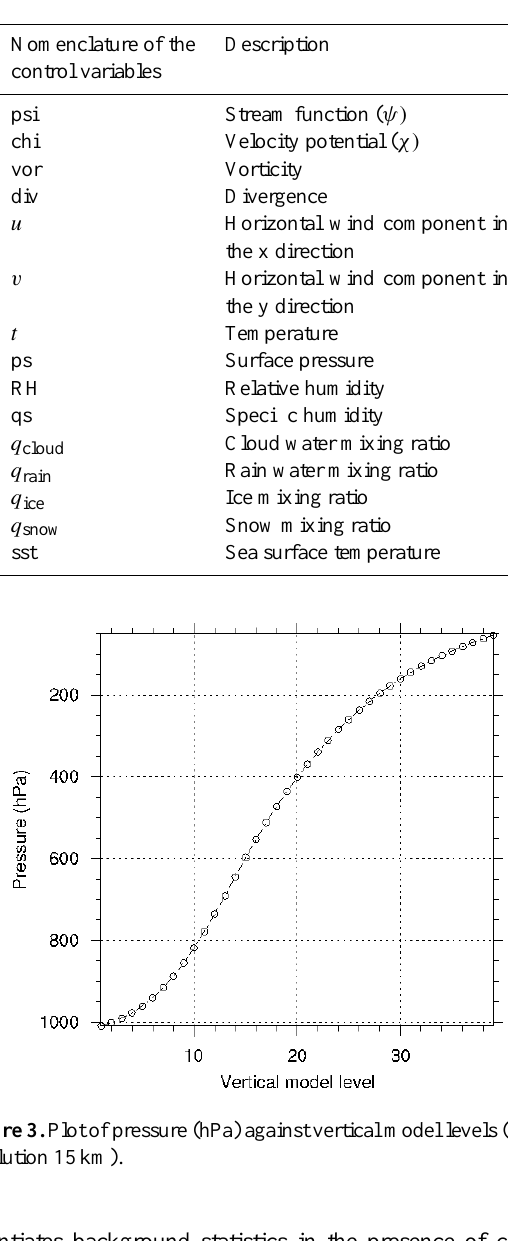
Table 1. Description of the control variables available for the mete- orology.